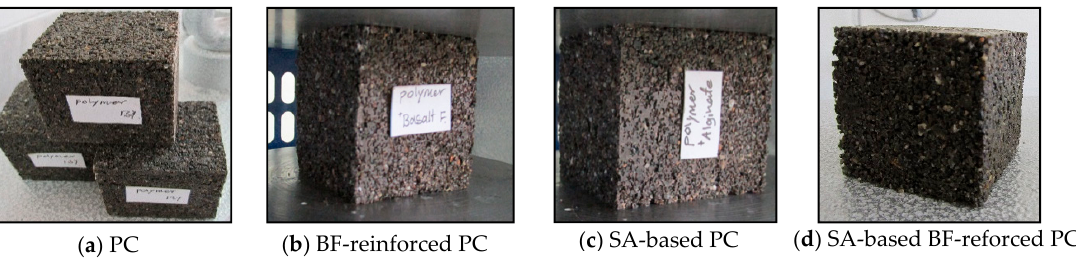
Figure 3. Failure of samples under compression test.